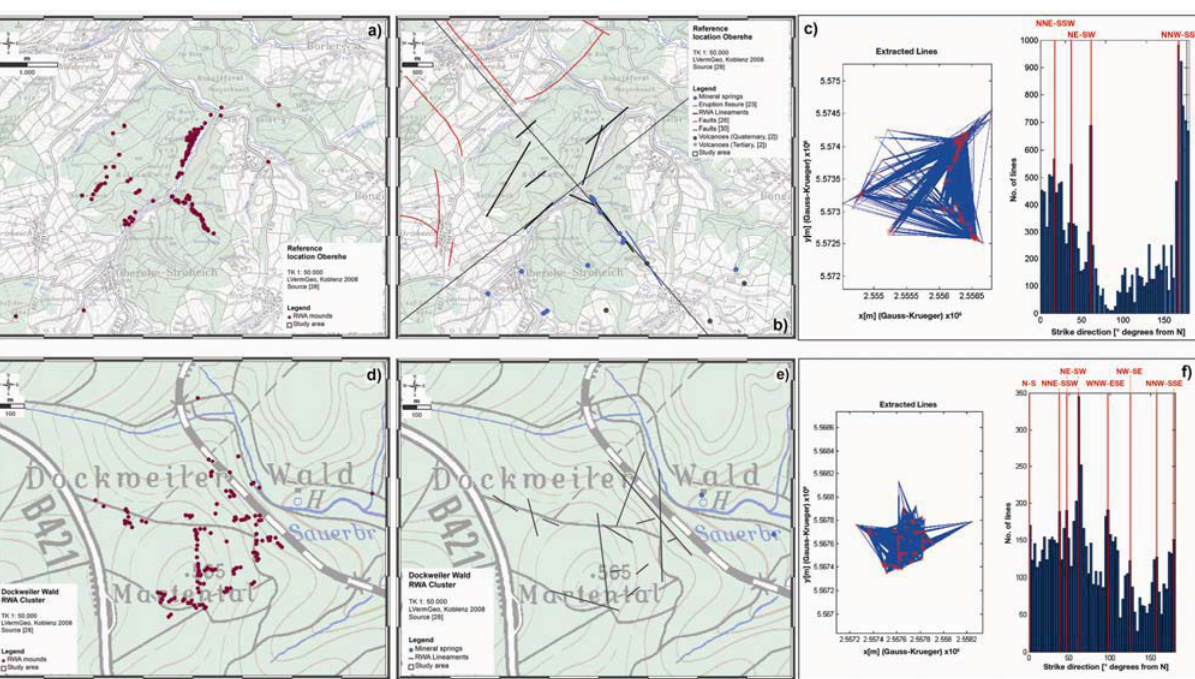
Figure 10. Spatial distributions of RWA (red dots) ( a ), manually inferred RWA Lineaments (grey lines) ( b ) combined with published tectonic features like faults (red lines), eruption fissures (blue lines) and mineral springs (blue dots) and results of the modified Hough Transform ( c ) for the Oberehe site. For the RWA cluster at the Dockweiler Wald area ( d ), manually inferred RWA lineaments (grey lines) and mineral springs (blue dots) ( e ) and results of the modified Hough Transform ( f ) are